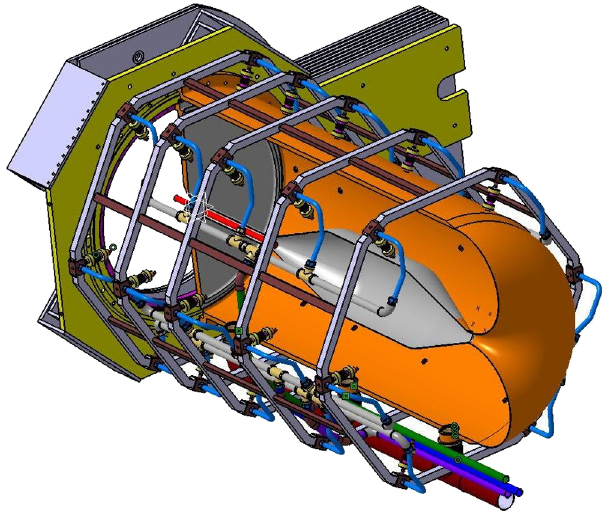
FIG. 21. Horn with strip lines and cooling